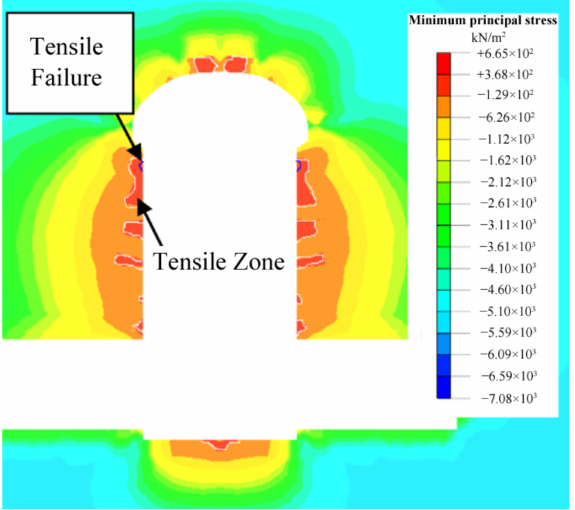
Figure 10. Minimum principal stress distribution after dynamic